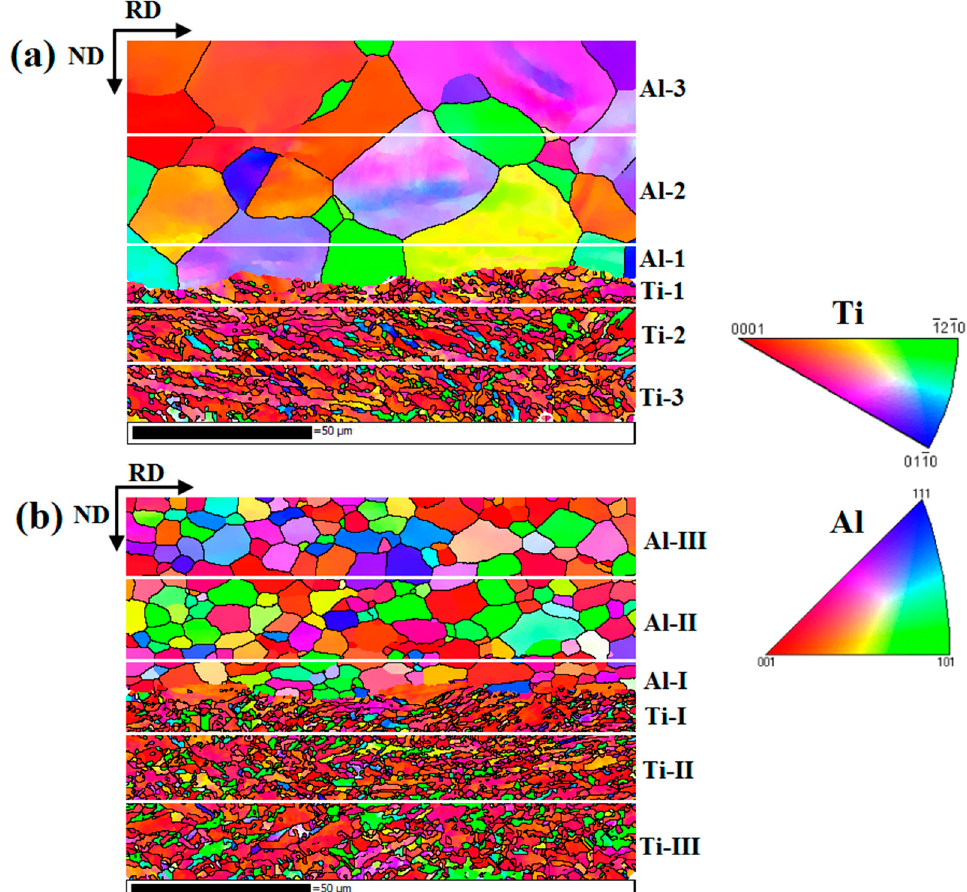
Figure 15. EBSD maps near the Ti/Al interface under different initial strengths of aluminium. ( a ) Specimen B3; ( b ) specimen C3.